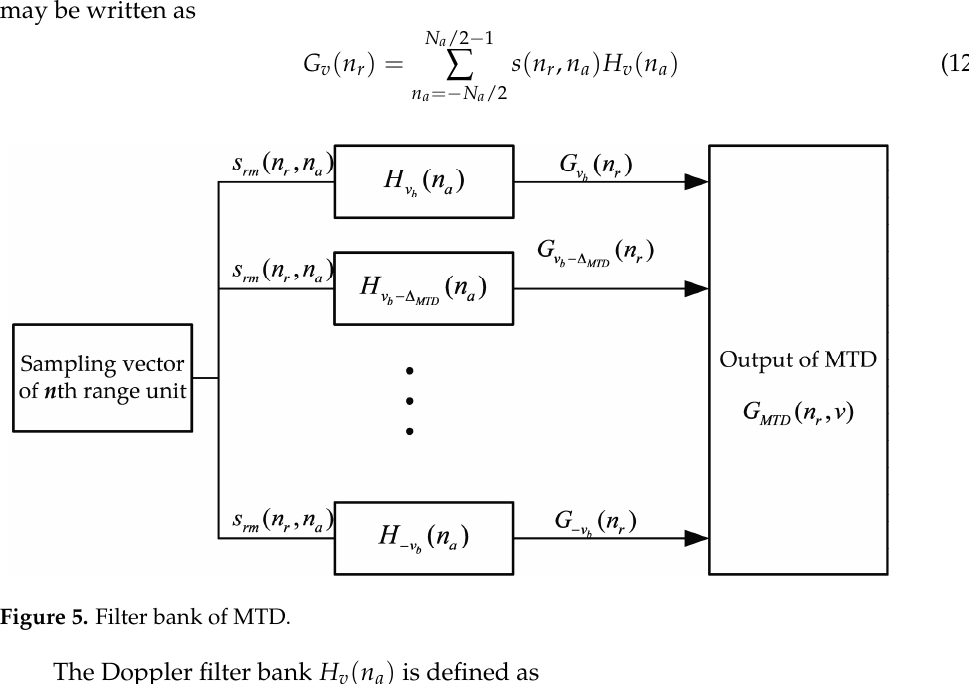
Figure 5. Filter bank of MTD.